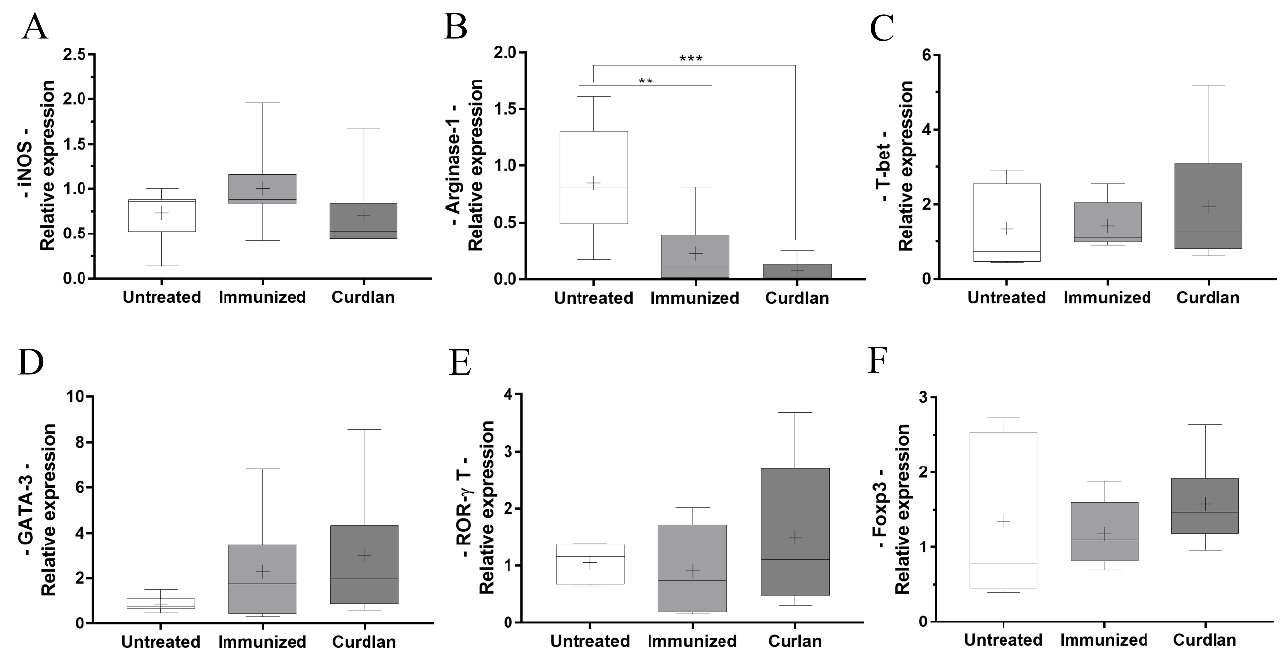
Figure 6. Relative expression of transcription factors related to macrophage polarization and T-helper cell differentiation in the lungs of BALB/c mice treated with curdlan and immunized with HK- C. gattii . Lungs were harvested from the mice 14 d.p.i., and total RNA was extracted from the lungs. The total RNA was reverse-transcribed into complementary DNA (cDNA), and the relative expression levels of ( A ) iNOS , ( B ) Arginase-1 , ( C ) T-bet , ( D ) GATA-3 , ( E ) ROR- γ t , and ( F ) FOXP3 were determined by real-time quantitative polymerase chain reaction (qRT-PCR). The values were normalized to β -actin expression. The results are expressed as median, maximum, and minimum values. Comparisons were made between groups for the same period of infection. ** p < 0.01, and *** p <